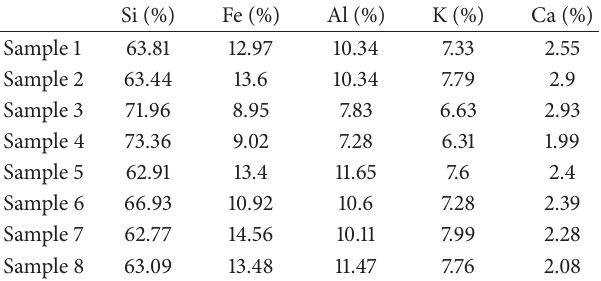
Table 1: Measured concentrations of major elements in the coastal